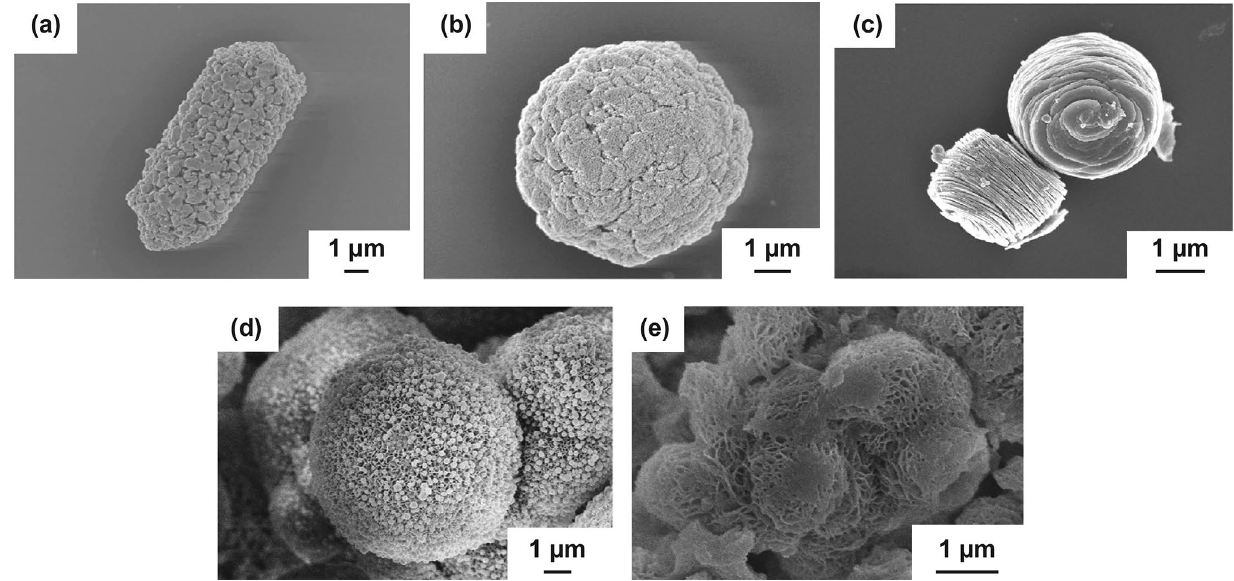
Fig. 7 FESEM images of NiCo 2 O 4 architectures prepared solvothermally using different solvents a water, b isopropanol, c 1:1 ethanol: water, d pure ethanol, and e diethylene glycol. Reproduced with permission from Ref. [122]. Copyright © 2017 American Chemical